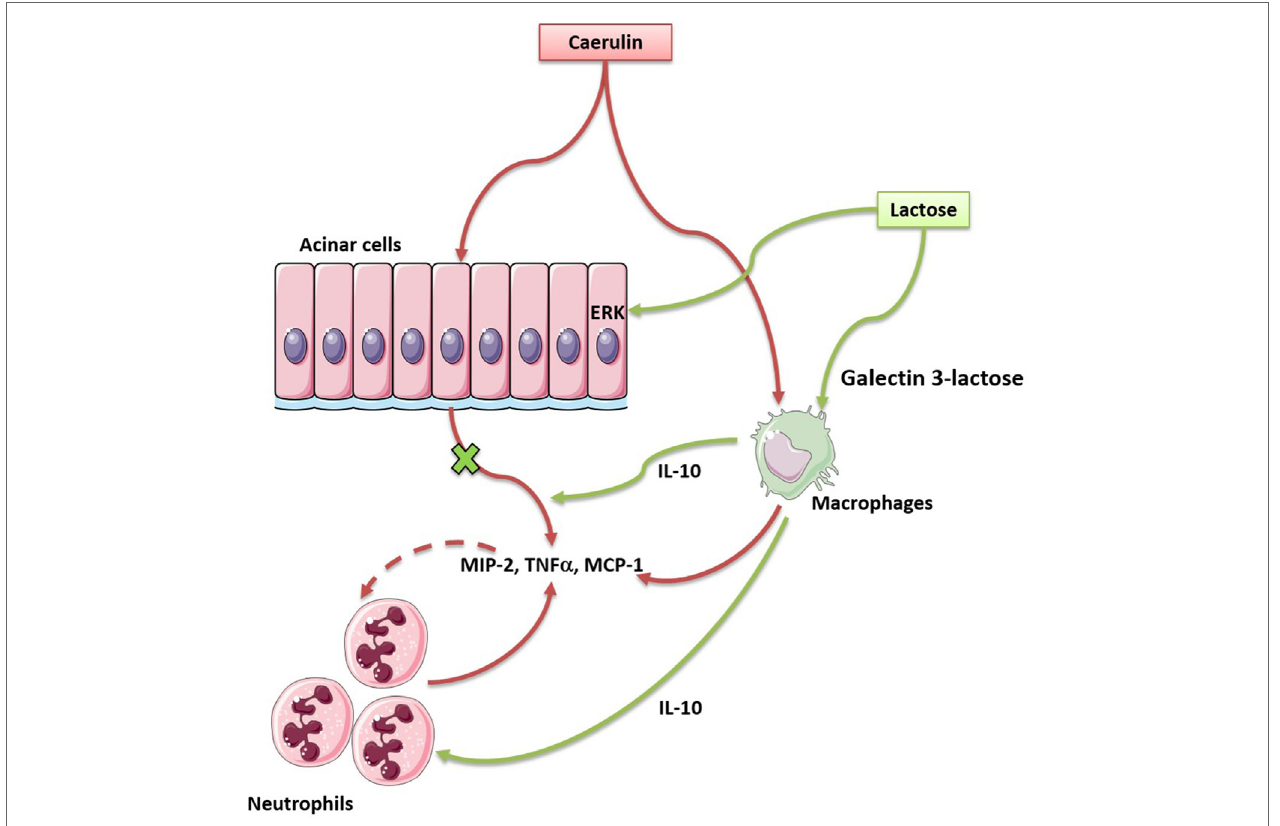
FigUre 7 | Lactose promotes modulatory immune responses during caerulein-induced experimental acute pancreatitis (AP) by antagonizing galectin-3. In our study, lactose protects mice against AP induced by caerulein via regulating the infiltration of neutrophils and macrophages, reducing the release of inflammatory mediators especially the cytokine tumor necrosis factor alpha and the chemokine monocyte chemotactic protein-1, inhibiting ERK1/2–p65 activation. In addition, lactose treatment promotes IL-10-producing macrophages in the pancreas and may bind galectin-3 to alleviate the severity of